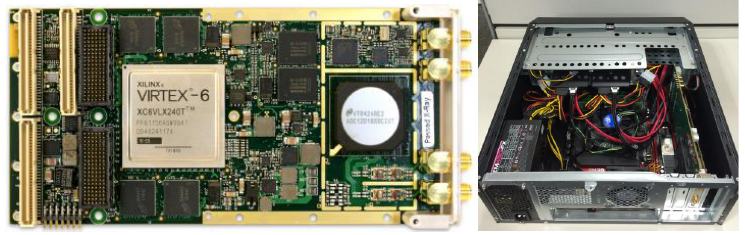
Figure 7. PRC module and data recorder box.